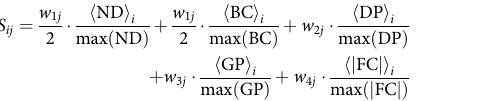
invasive bladder and breast cancer cell lines. In particular, we used RT-4 as non-invasive and UM-UC-3 as invasive cell lines in bladder cancer, whereas MCF-7 as non-invasive and MDA-MB231 as invasive cell lines in breast cancer. Differential expression analysis was performed using the DEseq R-package with method = ‘ bind ’ and fi tType = ‘ local ’ (v1.22.1) 71 . Furthermore, we calculated the absolute average fold-change for a motif based on the change in expression values